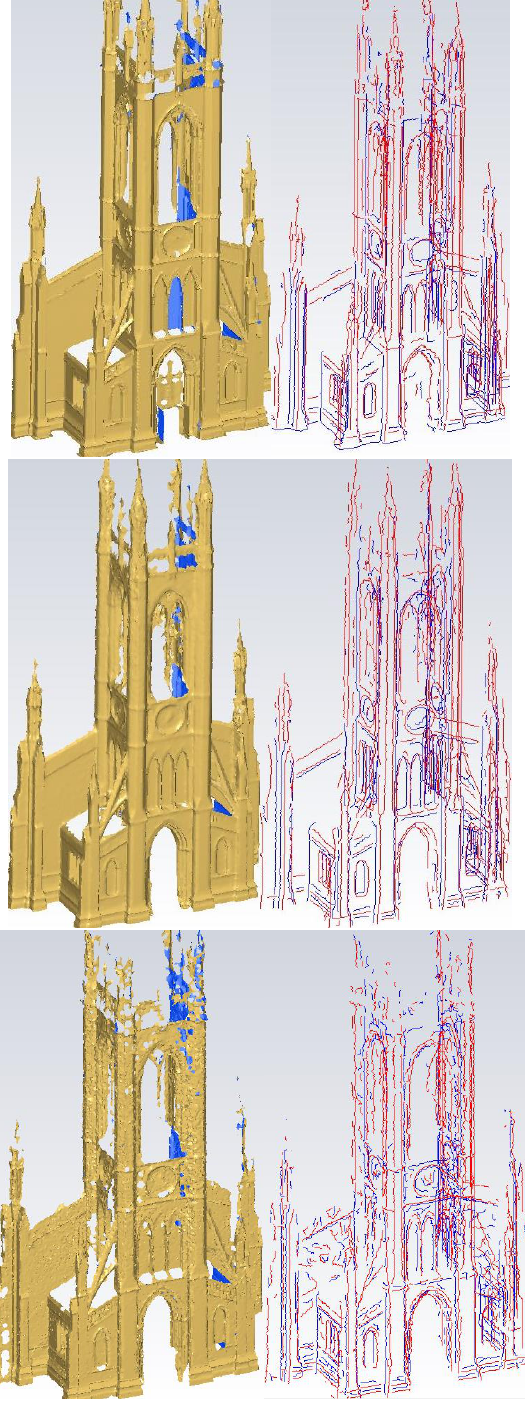
Figure 12. Mesh and breakline extraction from point clouds. Top to bottom: Laser scan, Photoscan, MicMac.